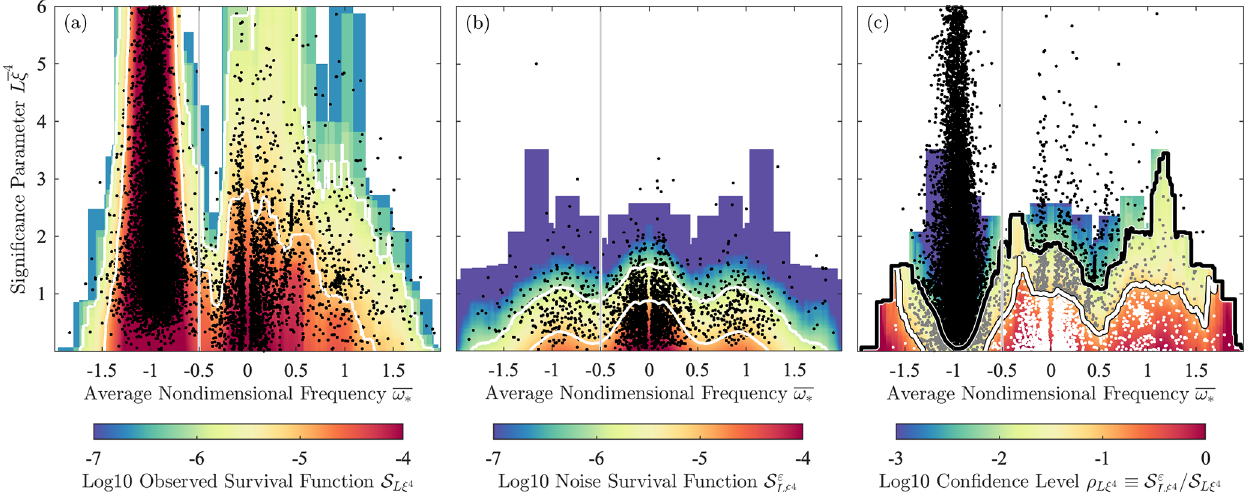
Figure 14. A significance criterion for wavelet ridges in the Gulf of Mexico surface drifter dataset. The black dots in panel (a) show the locations of all ridges on the plane of the ridge-averaged nondimensional frequency | ω ∗ | versus Lξ 4 , the product of ridge duration and fourth power of the ridge-averaged circularity. Bin-averaging in nondimensional frequency bins of width (cid:49)ω = 1 / 4, and then cumulatively summing along the y axis from high values to low values, leads to an object called the complementary cumulative distribution function or survival function S X (x ; ω) for X = Lξ 4 , constructed here to be a function of frequency. The logarithm of the survival function is shown as the colored shading in (a) , with white lines being the 10 − 5 and 10 − 6 contours. Panel (b) is the same as (a) but for the noise dataset. Since this dataset is 10 times the size of the observations, for display purposes only 10% of the dots are shown, and the histogram is divided by a (x ; ω)/ (cid:98) S X (x ; ω) is shown factor of 10, thus making panels (a) and (b) directly comparable. Finally the logarithm of the ratio ρ X (x ; ω) ≡ (cid:98) S ε X in (c) . The heavy white line in this panel marks the ρ X (x ; ω) = 0 . 1 contour such that only 1 out of 10 events above this curve is expected to be a false positive. Similarly, the black line is the ρ X (x ; ω) = 0 . 01 contour, above which only 1 out of 100 events is expected to be a false positive. Dots in this panel are those of the data, the same as in (a) . The black and gray dots mark observed ridges falling above the 0.01 and 0.1 contours, respectively. Those falling below the ρ X (x ; ω) = 0 . 1 contour, shown as white dots, are judged to be statistically insignificant. The thin vertical gray line in all panels marks ω ∗ = − 1 / 2. Events to the left of this line likely represent inertial oscillations, apparent as the prominent peak in the vicinity of ω ∗ = − 1, rather than coherent